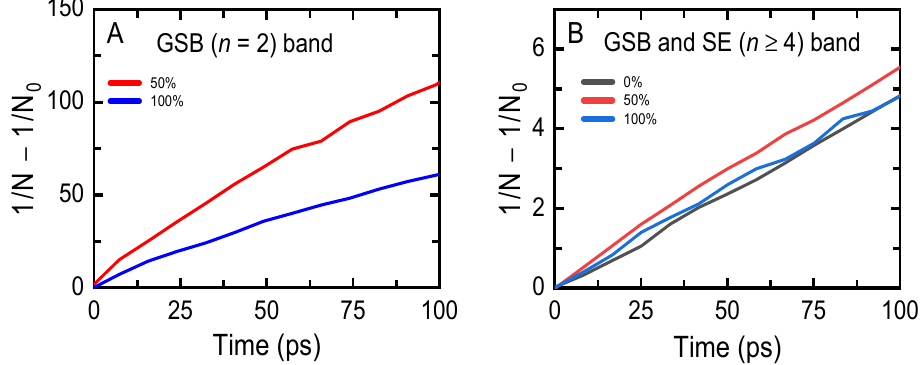
Figure 7. Time evolution of the inverse relative bleaching (1/ N ) obtained from the TA signal in the GSB bands from the n = 2 domain in samples with a 50% and 100% excess of RbBr ( A ) and emitting n ≥ 4 domains in all samples ( B ). The detection wavelengths were approximately 430 nm ( A ) and 470–490 nm ( B ).